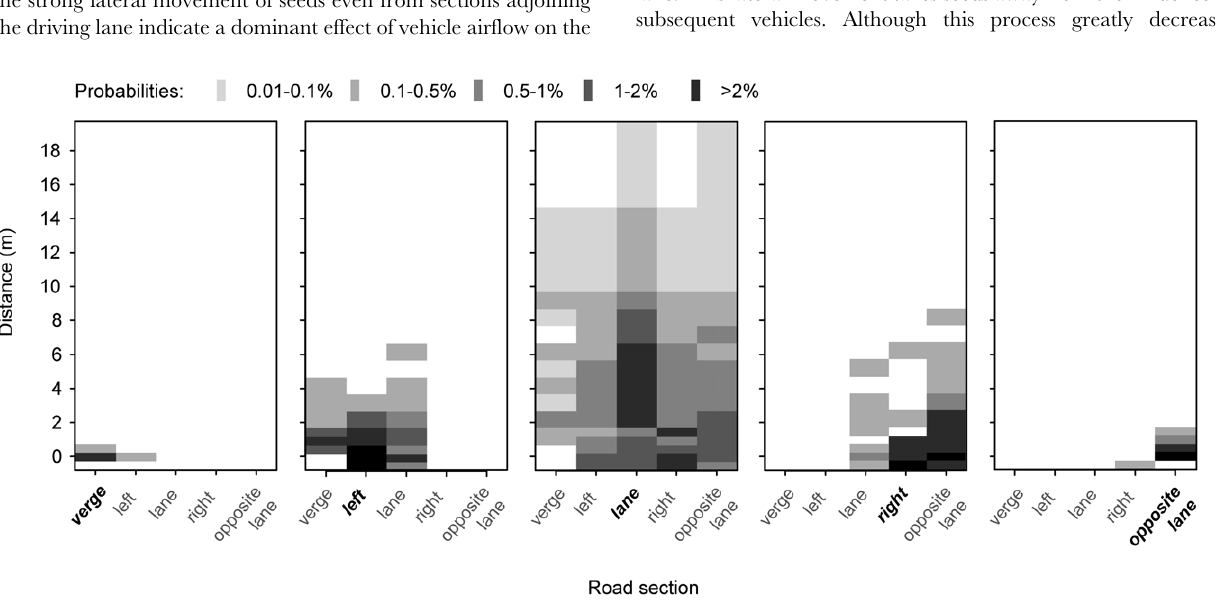
Figure 5. Influence of the starting section on parallel and lateral movement of seeds by a passing car. Dispersal patterns of Ailanthus altissima seeds after one vehicle pass for seeds initially placed in the verge (left panel), the left side (second panel from left) the driving lane (centre panel), the right side (second panel from right) and the opposite lane (right panel). Probabilities of reaching the different sections of the study road are indicated by different grey shading. Probabilities are averaged over 50